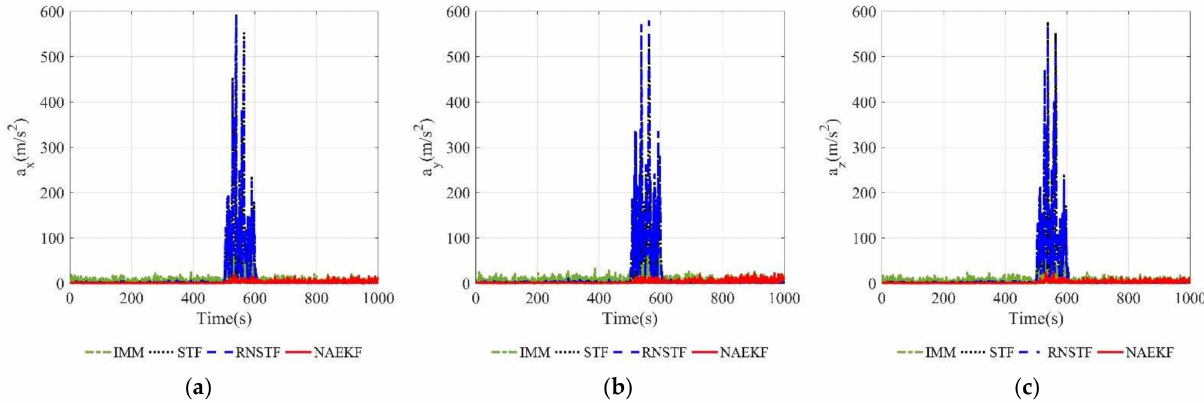
Figure 15. σ -Boundary of velocity estimation errors. ( a ) σ -Boundary of v x ; ( b ) σ -Boundary of v y ; ( c ) σ -Boundary of v z .